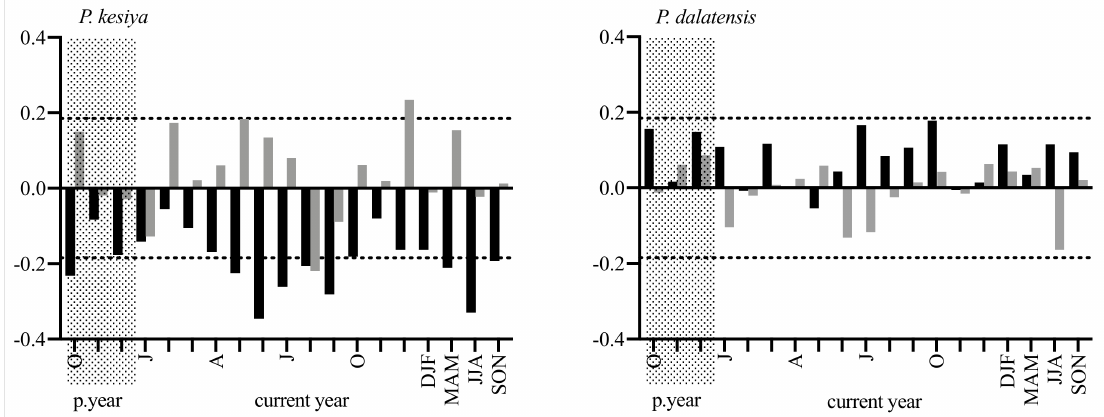
Figure 3. Correlation coefficients of tree-ring indices of the two pine species with temperature ( black bars ) and precipitation ( grey bars ) from 1901 to 2013. Dotted lines indicate thresholds of significance at p < 0.05. The letters on the x -axis indicate calendar months and seasonal periods. DJF : December (preceding year) to February; MAM : March to May; JJA : June to August; SON : September to